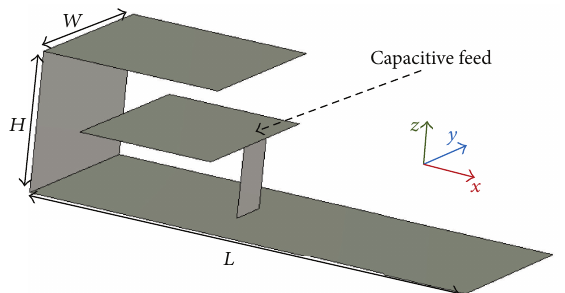
Figure 1: Example of a typical monitor chassis; the available space for the antenna is highlighted in a light color.